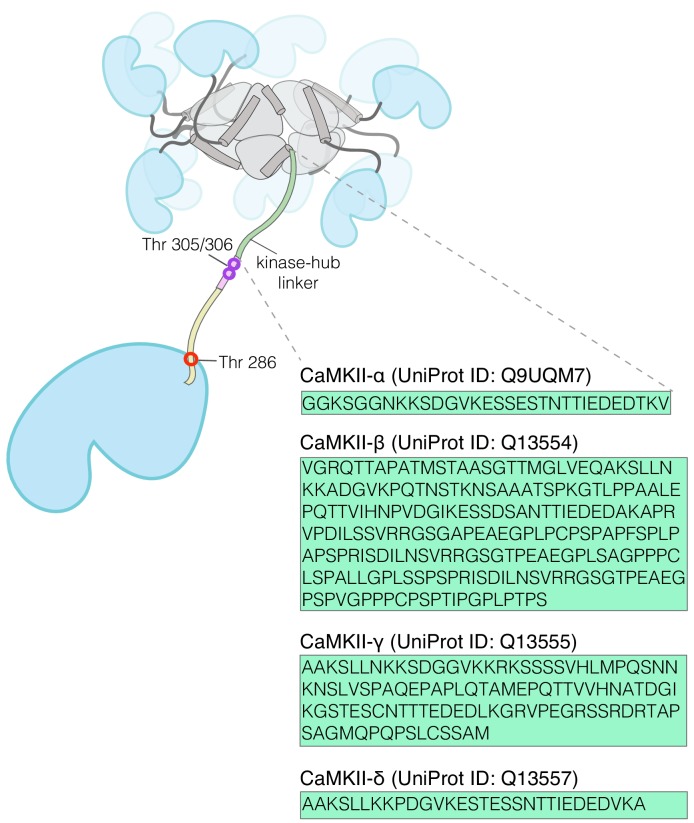
Amino acid sequences for the kinase-hub linker in the four isoforms of human CaMKII.